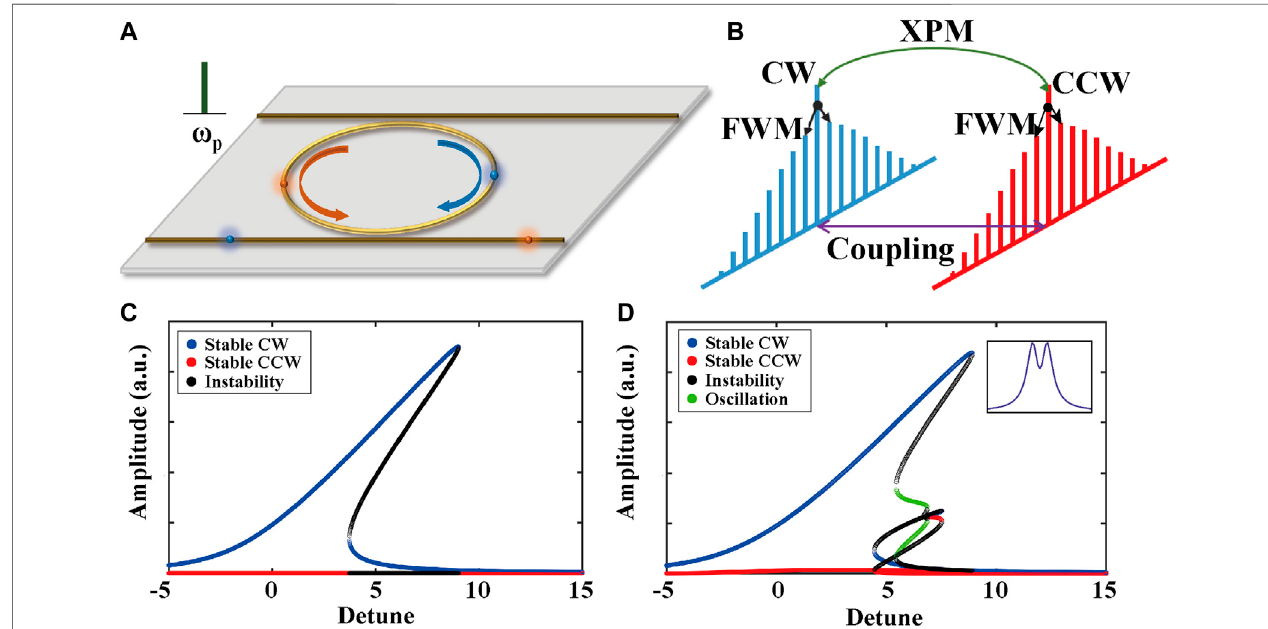
FIGURE 1 | Comparison of SMC generation in negligible and strong counterpropagating mode-coupling effects in microresonators. (A) Schematic of SMC generation in a CW and CCW coupled microresonator. Two counterpropagating microcombs are spontaneously formed with a monochromatic pump at frequency ω p . (B) Principle of coupled CW and CCW microcomb formation. The counterpropagating microcombs are linear and nonlinear coupled due to the Rayleigh backward scattering and XPM in the microresonator. When the microcomb forms in the cavity, the other frequency parts of CCW and CW waves are also linked by XPM and mode-coupling. (C,D) Effectofweakandstrongcounterpropagatingmode-couplingonthetransmissiontraceswhileapumpsweepsacrossaresonance.Thevaluesof weak mode-coupling and strong coupling are, respectively, 0 and 1. The value of the external pump f is 3. Inset in (D) shows the linear transmission traces under lower pump power. For high pump power, the symmetry of resonance is spontaneously broken, which is indicated by suppression of the CCW power, and a multi-stable regime is formed. The green region supports the breathing microcomb solutions.